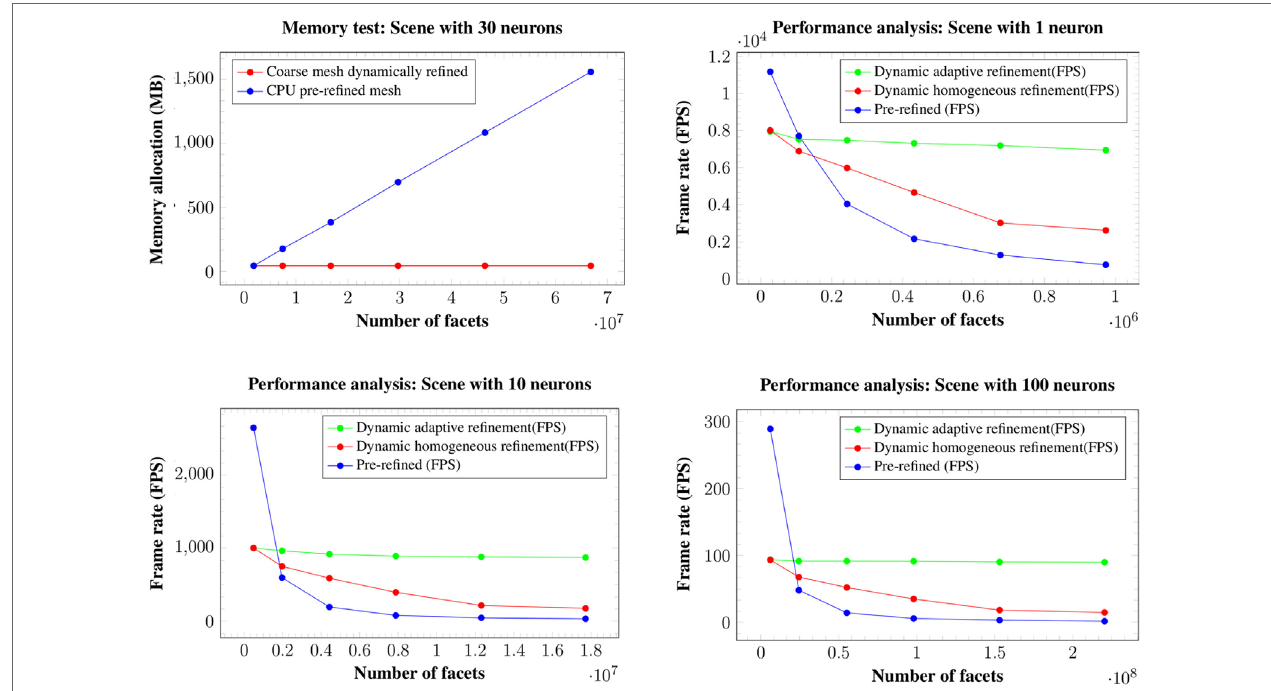
FIGURe 15 | Memory consumption for the 30 neurons scene at 6 different levels of refinement (top left image). Changes in the level of refinement are represented by the dots in the graphics. Both our homogeneous and our adaptive refinement approaches (in red), even including the extra data necessary to apply the refinement, require less memory than storing the pre-refined mesh in the graphic card (in blue). Performance in FPS for the scenes with a single neuron (top right image), ten neurons (bottom left image), and one hundred neurons (bottom right image). Changes in the level of refinement are represented by